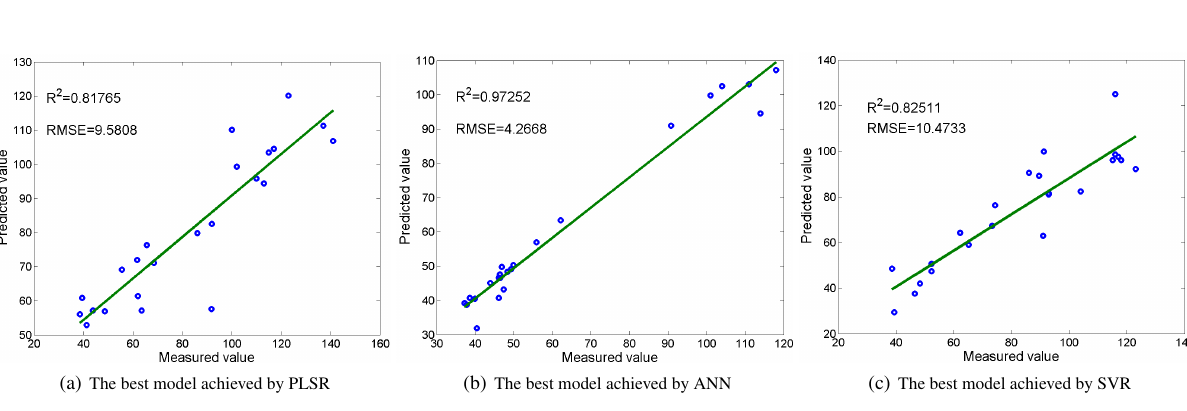
Table 3. Statistics of coefficients of determination